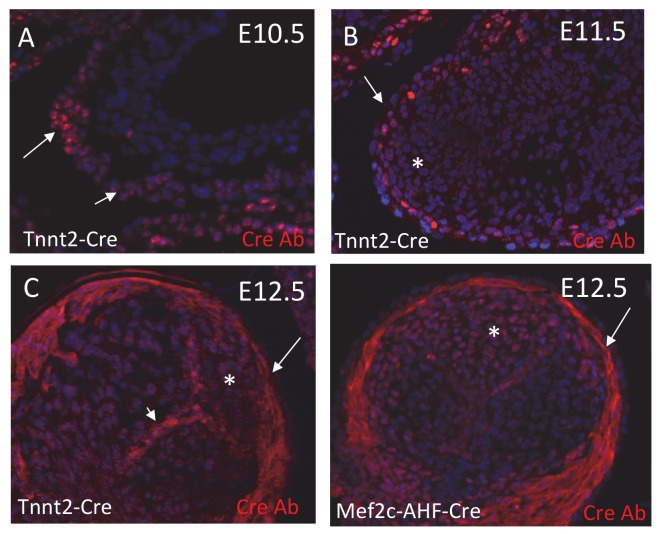
Confirmation of timing of Cre expression.(A-D) Anti-Cre antibody shows that ICVS cells (arrowheads) in Tnnt2-Cre+ embryos no longer express Cre protein by E11.5, showing that the Tnnt2 promoter was down-regulated prior to this stage. Cre protein expression is maintained in the myocardium (arrow) throughout the time points examined. (L) Cre protein is expressed in the myocardium and in ICVS cells in Mef2c-AHF-Cre+ embryos at E12.5 showing that the Mef2c-AHF enhancer remains active up to at least E12.5.